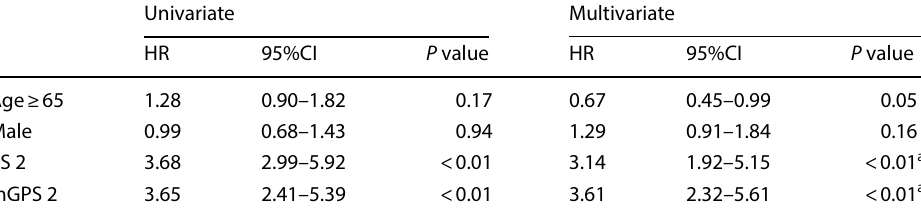
Table2 Univariate and multivariate analysis of